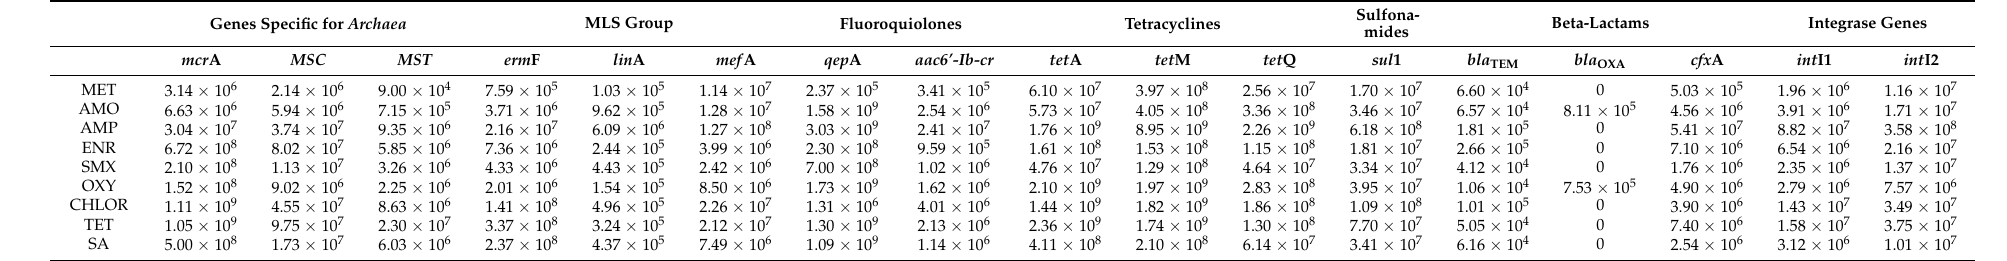
Table 2. Absolute abundances (AAs) of genes specific for Archaea , antibiotic resistance genes, and integrase genes in digestate with antibiotic addition and substrate without antibiotic addition. AAs were calculated as copy number of an antibiotic resistance genes in 1 g digestate (g D − 1